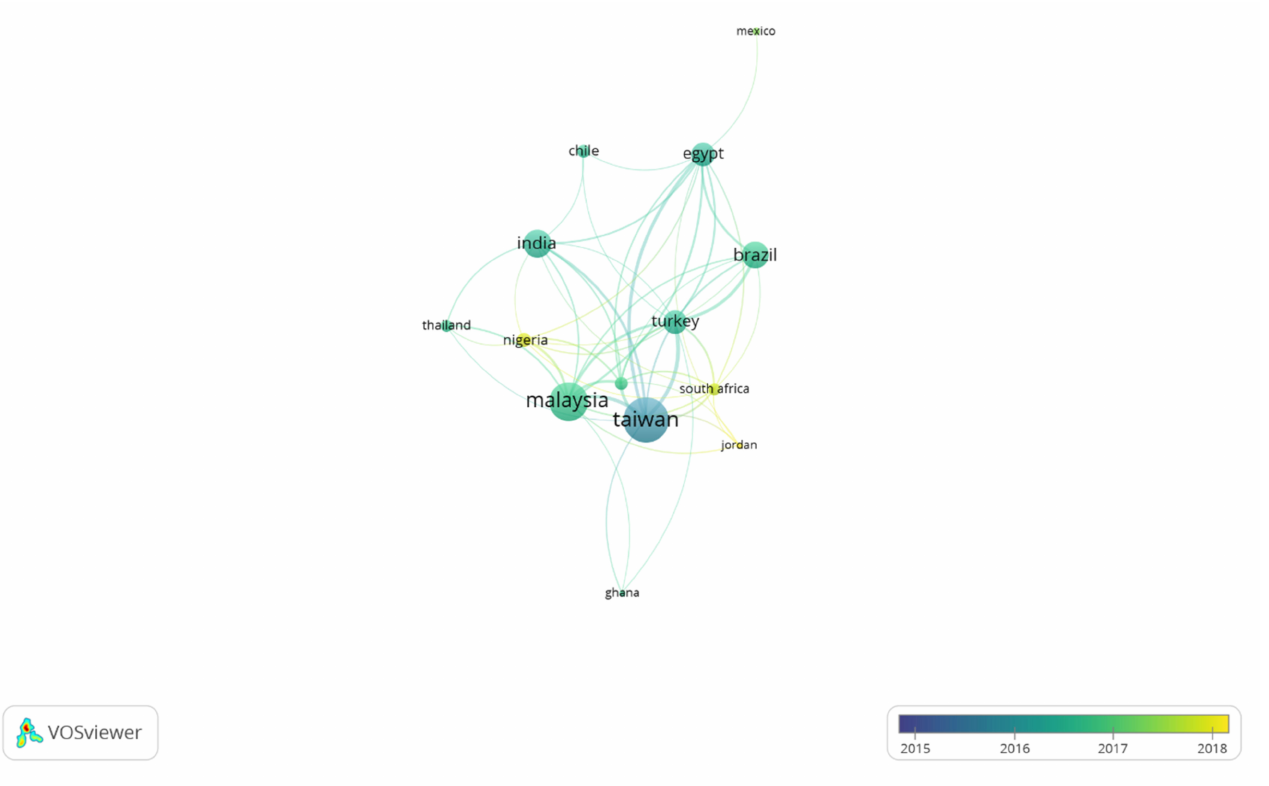
Figure 6. Network of